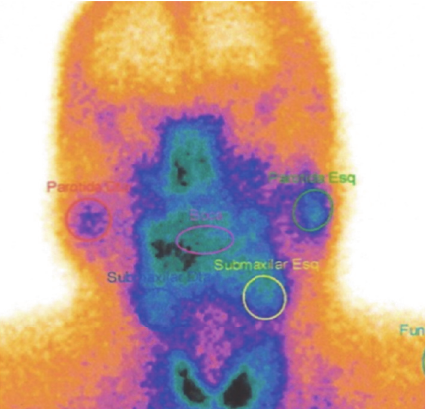
Figure 2: Salivary gland scintigraphy showing decreased uptake in submaxillary and